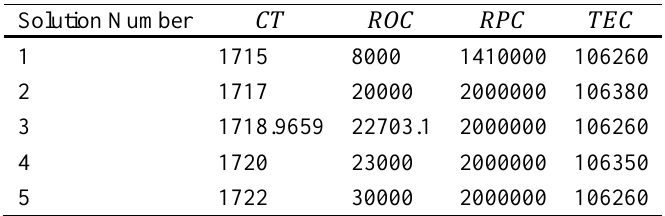
Table 3. Goal programming method optimal Pareto